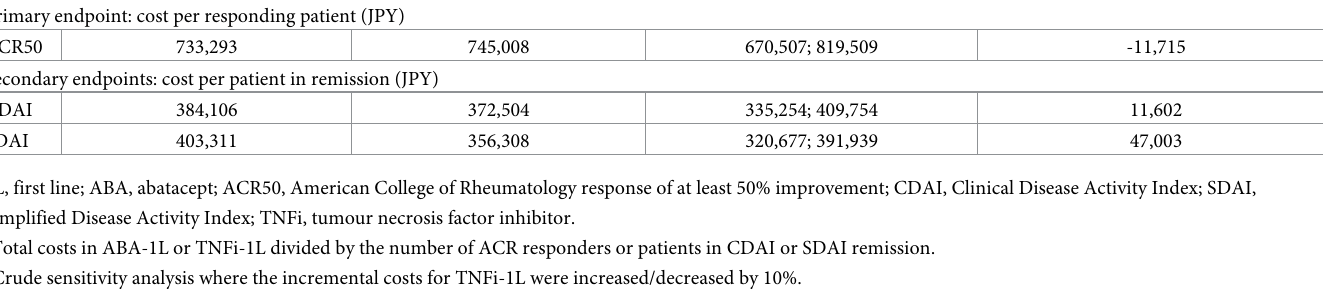
Table 5. Cost per responder and patient in remission–per member per month (ABA-1L vs. TNFi-1L). Cost per health gain a (ABA-1L)